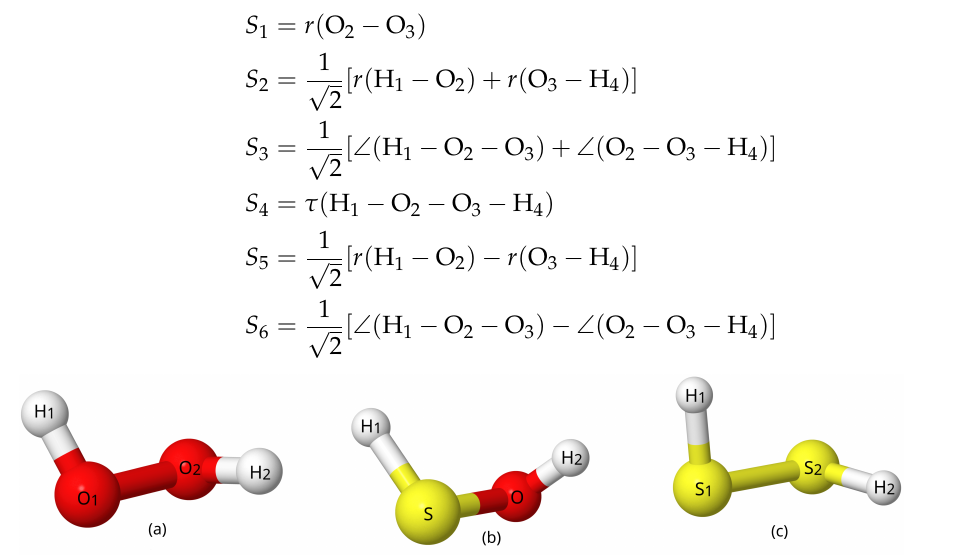
Figure 1. Visual depiction of the optimized structures for ( a ) HOOH, ( b ) HOSH, ( c )